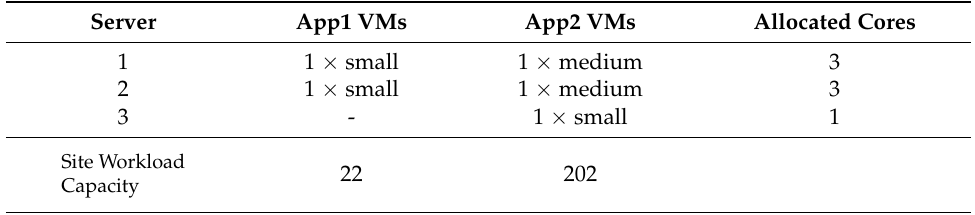
Table 4. VM formations in Slot